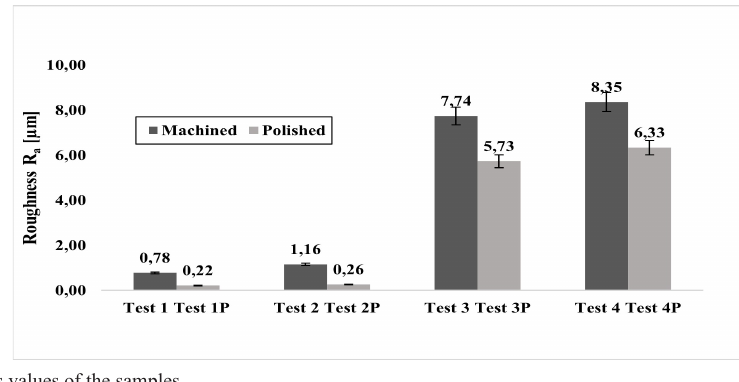
Figure 2. Roughness values of the samples.